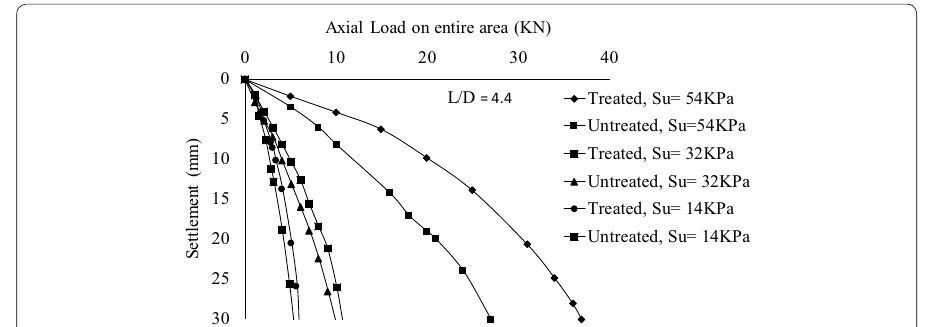
Fig. 6 Effect of sand column on clayey soil of different shear strength